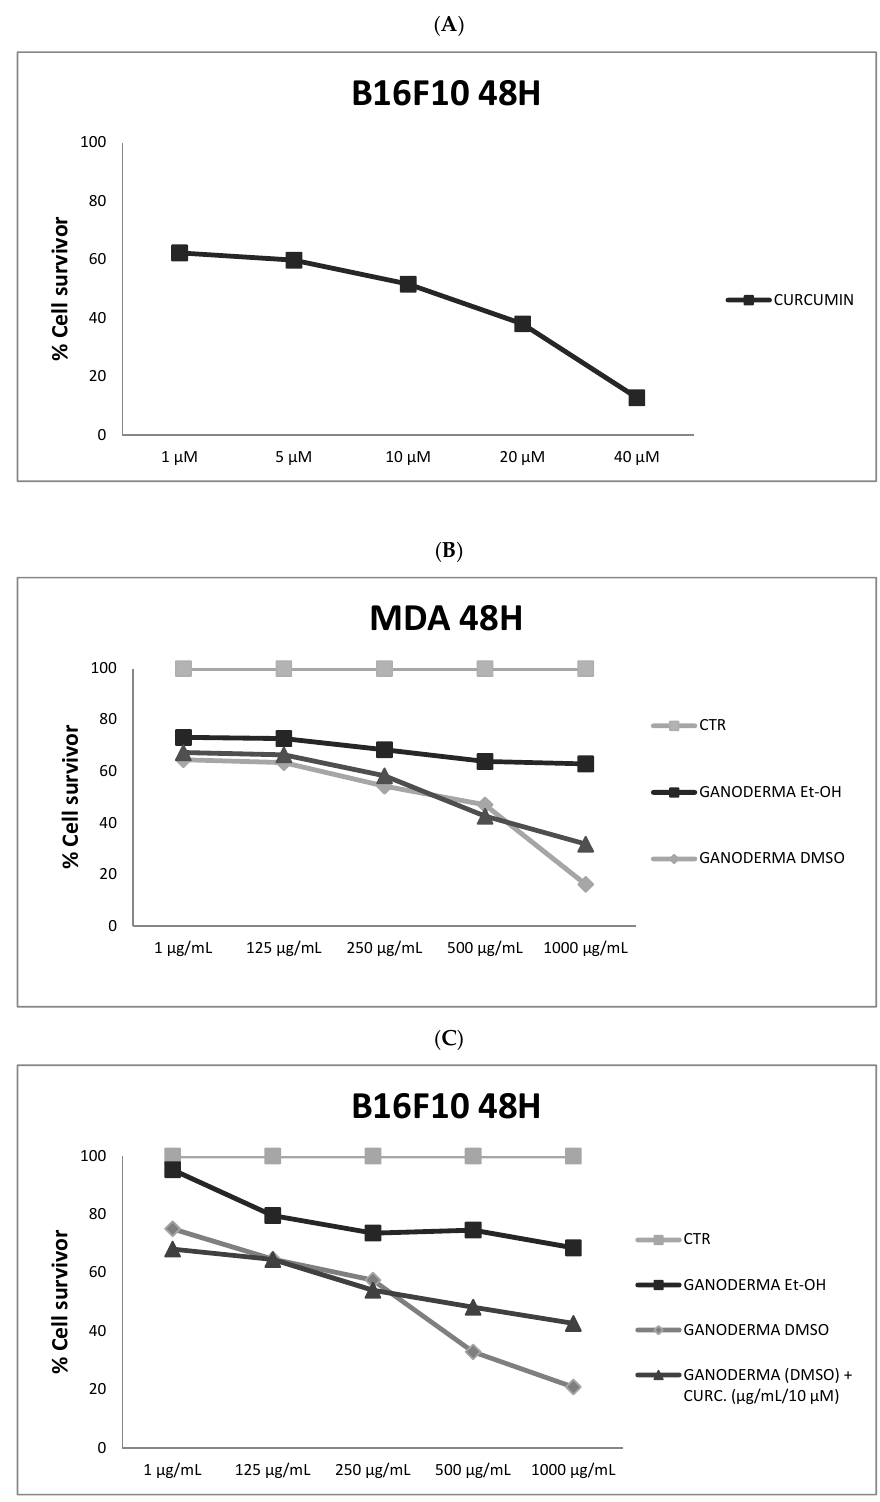
Figure 2. MTT assay. ( A ) Inhibitory effect of curcumin (IC 50 = 10 µ M); ( B , C ) MDA-MB231 and B16-F10 cells were plated on a 96-well plate and incubated with Ganoderma lucidum extracts at different concentrations (1 µ g/mL; 125 µ g/mL; 250 µ g/mL; 500 µ g/mL; 1000 µ g/mL), and also combined with curcumin 10 µ M for 48 h. The experiment was repeated at least three times. CTR = control; Et-OH = Ethanolic extract; DMSO = dimethyl sulfoxide extract; CURC =